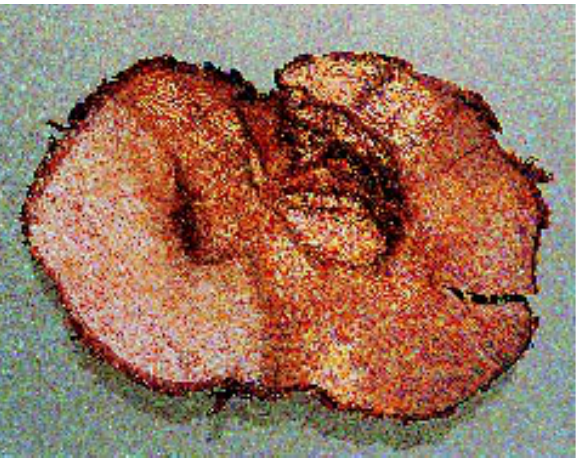
Fig. 2. Wood necrosis symptoms in a cross sectional cut of cv.